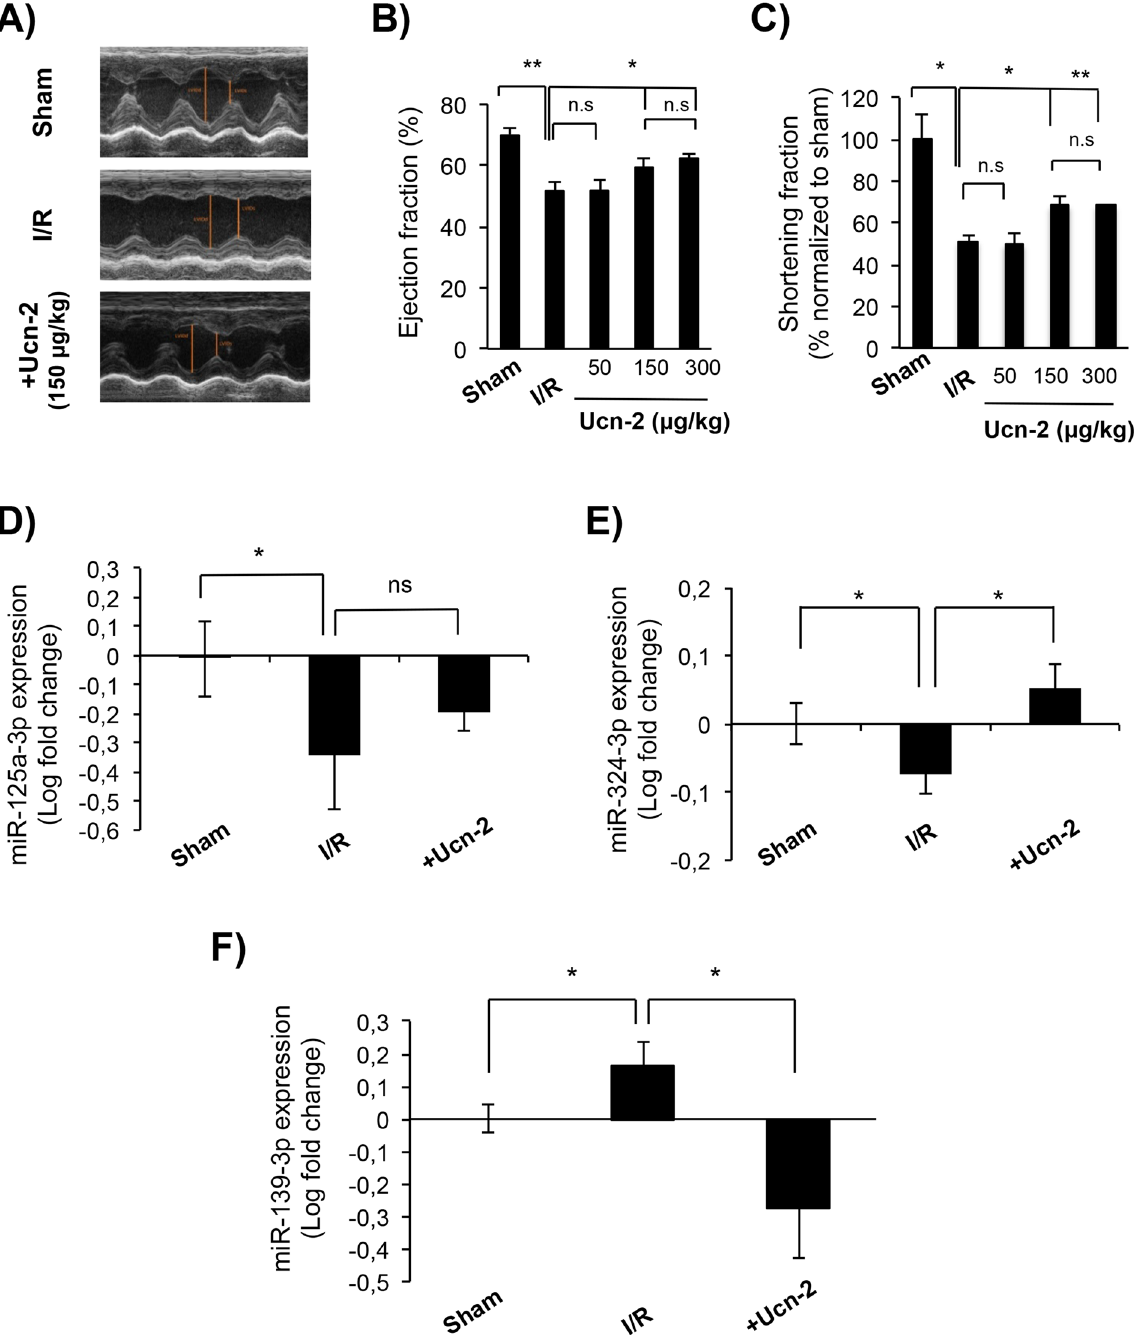
Figure 5. Infusion of urocortin-2 improves cardiac function in I/R and regulates the expression of miRNAs. ( A ) Cardiac function analyzed by echocardiography in M-mode 24 hours after surgery in three experimental models. Images are from “ Sham” (n = 5); from “ I/R ” group corresponding to rats undergoing occlusion of the left coronary artery (LCA) for 40 minutes followed by reperfusion (n = 6); and for I/R rats infused with Ucn-2 (150 µ g/Kg) 5 minutes before reperfusion (n = 5). ( B , C ) Bar graphs summarize ejection fraction (EF, %) and shortening fraction (SF, %) measured in rats infused with 50, 150 or 300 µ g/Kg of Ucn-2. ( D – F ) Bar graphs showing the expression of miR-125a-3p, miR-324-3p and miR-139-3p, respectively in hearts from Sham , I/R animal model, and from I/R rats infused with Ucn-2 (150 µ g/Kg; + Ucn-2). Values are shown in logarithmic scale. Data show means ± S.E.M. (n = 5–7). “ * ” and “ ** ” indicate significance at p < 0.05 and p < 0.01,